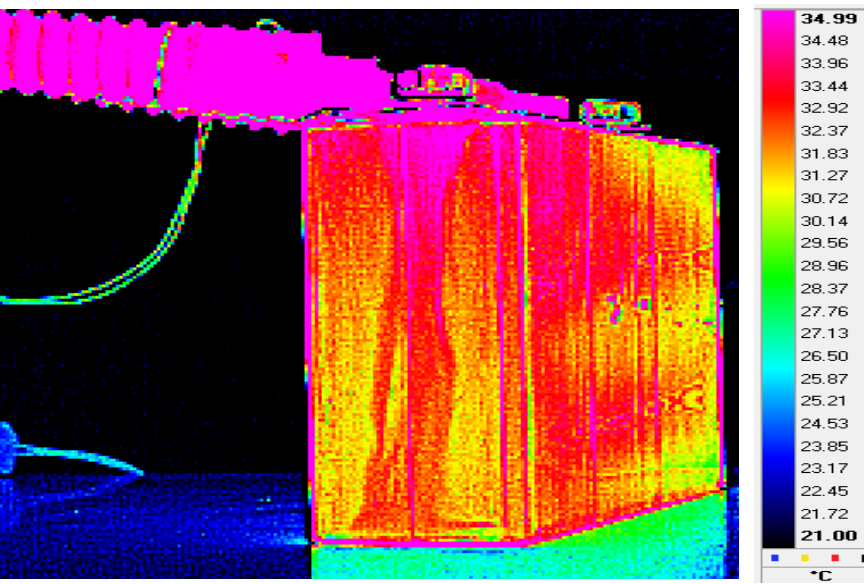
Figure 20. Infrared temperature measurement on a cell surface during NEDC cycling.